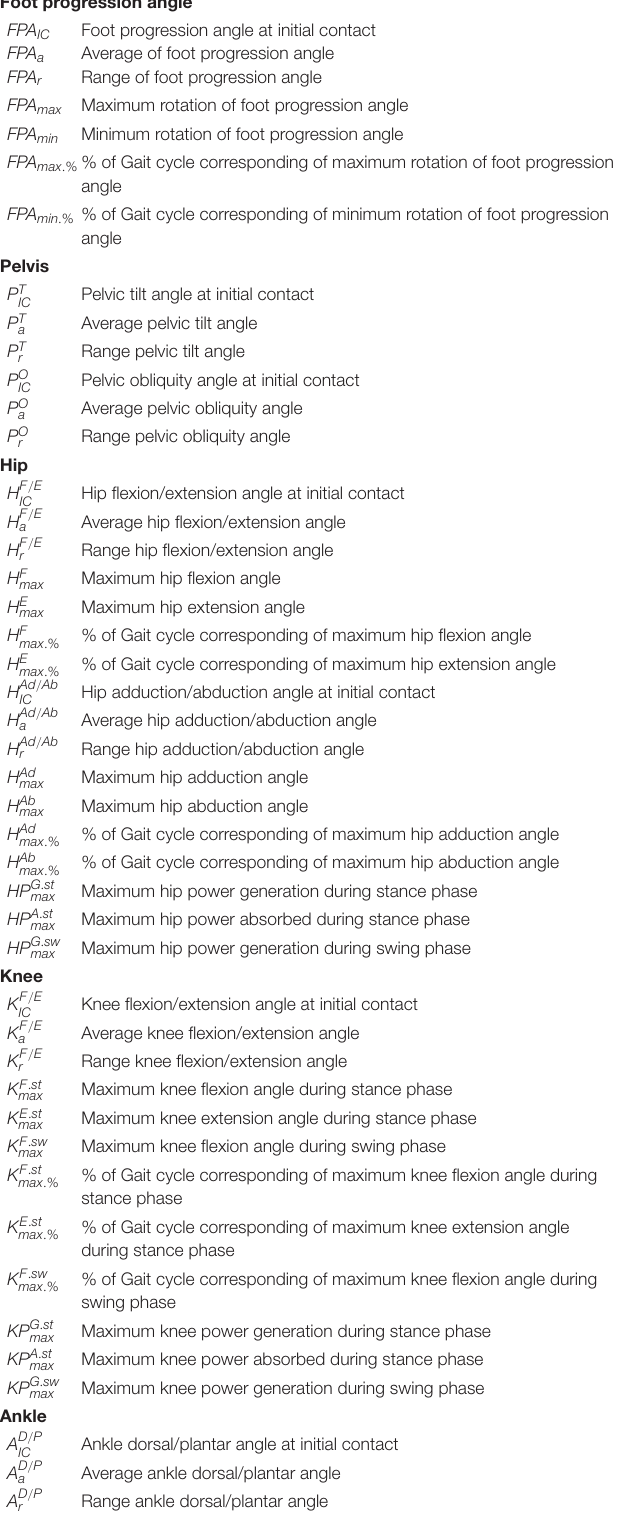
TABLE 2 | The list of the kinematic and kinetic variables of the lower limb (pelvis, hip, knee and ankle) and the absolute angles of thigh, leg and foot. Foot progression angle FPA